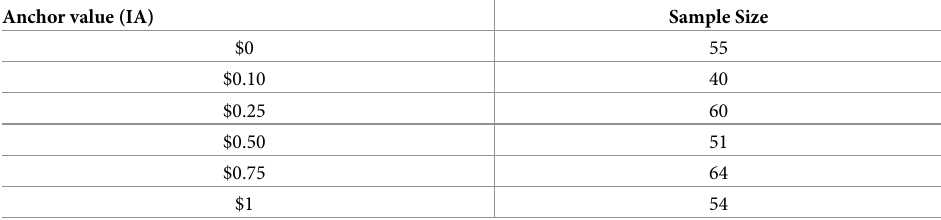
Table 1. Summary sample size by anchor.